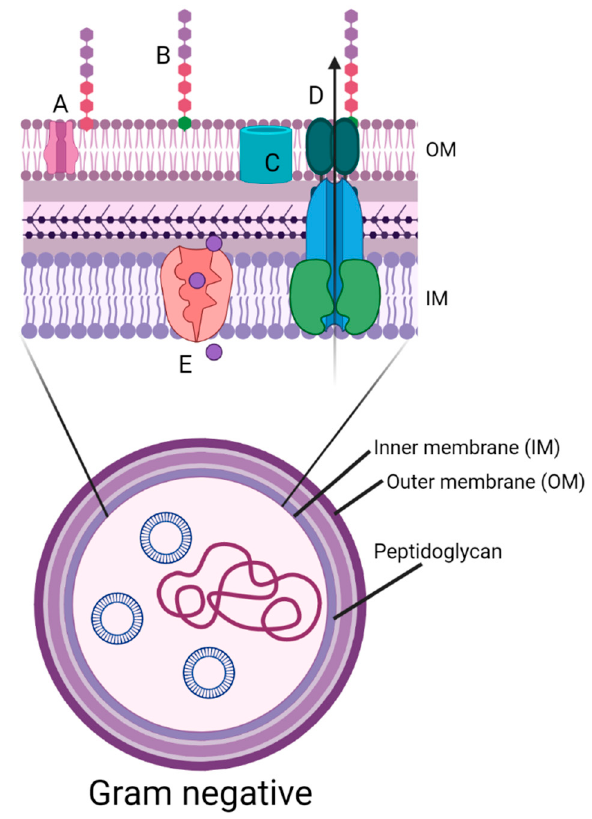
Figure 7. Diagram of the cell wall structure of a Gram-negative bacterium. Gram-negative bacteria possess an envelope that is composed of three layers. The first layer is the outer membrane (OM) The OM is composed of phospholipids, lipoproteins (A), lipopolysaccharide (LPS) (B) and proteins such as porins (C). The peptidoglycan cell wall is the second layer. The third layer is the cytoplasmic or inner membrane (IM). The IM is a phospholipid bilayer responsible for, inter alia, transport (D- efflux pumps) and sodium-potassium ions (E) [30]. The presence of the outer and inner membrane leads to decreased aPDI effectiveness against Gram-negative bacteria [31].